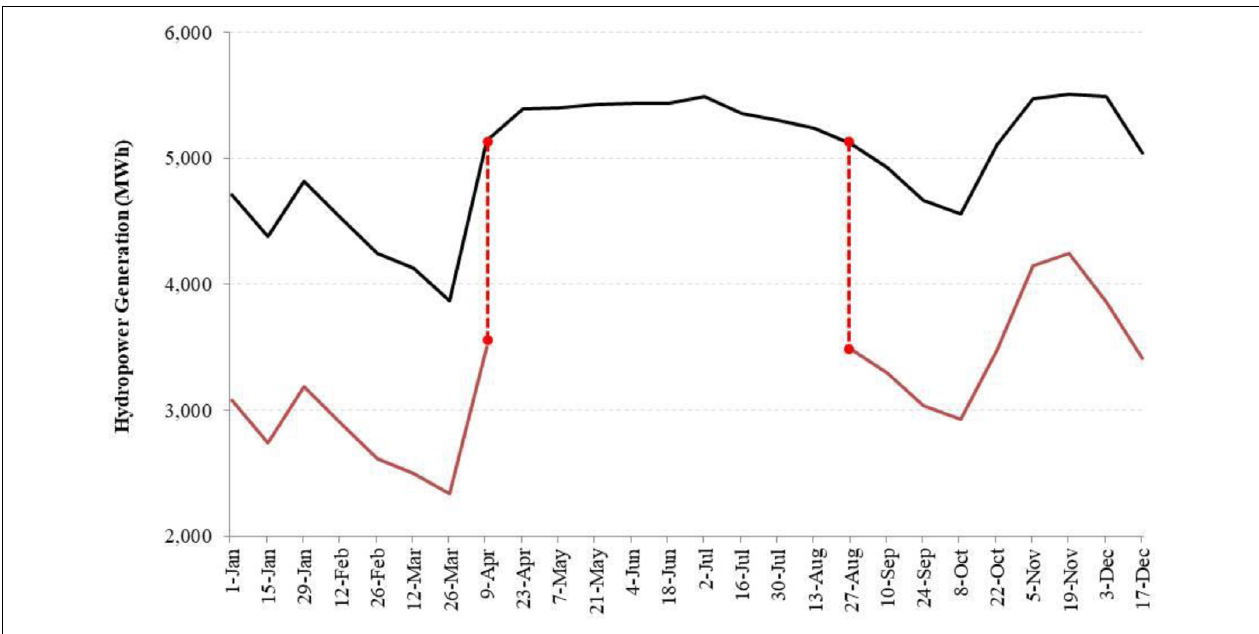
FIGURE 4 | Simulated losses in hydropower generation (MWh/2wk) at the Conklingville Dam as a consequence of the release of water to augment flows downstream at the Poughkeepsie Water Treatment Facility. Simulation carried out at the central values of all varying parameters (see Supplementary Figure S6 ). Black: actual 1995 generation; red: counterfactual 1995 generation with a deepened channel. Augmented flows were assumed to have been implemented during the fortnight beginning on August 27, 1995; the GSL was assumed to have been replenished to normal levels with the spring freshet by April 23,